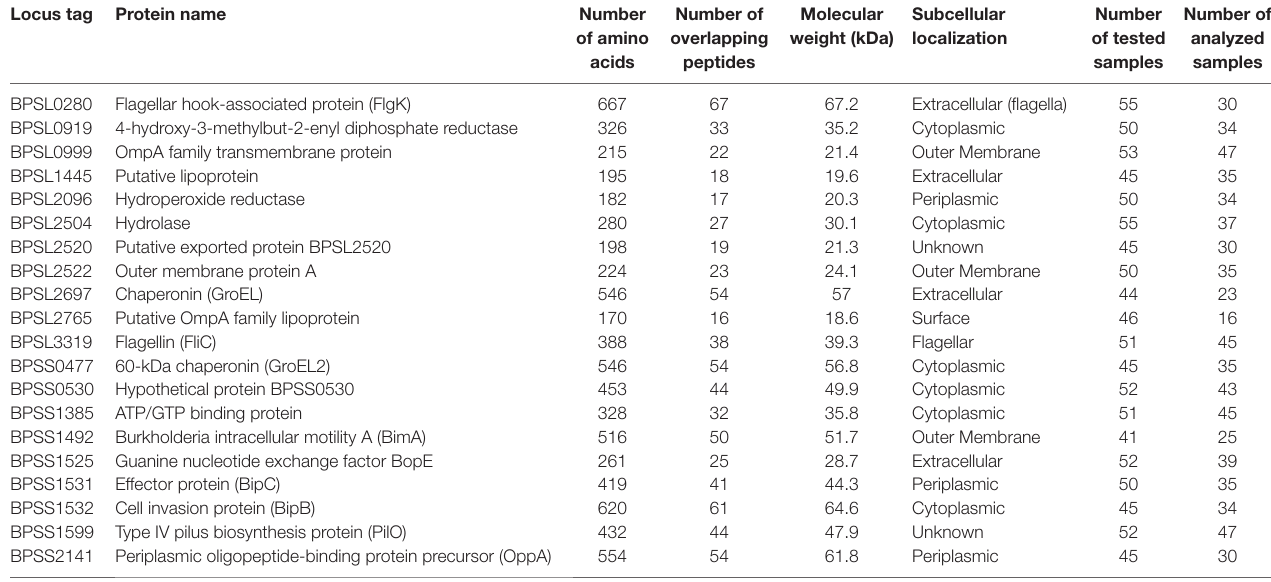
TaBle 1 | Listing and details of twenty Burkholderia pseudomallei candidate antigens for T-cell epitope mapping studies locus tag Protein name number